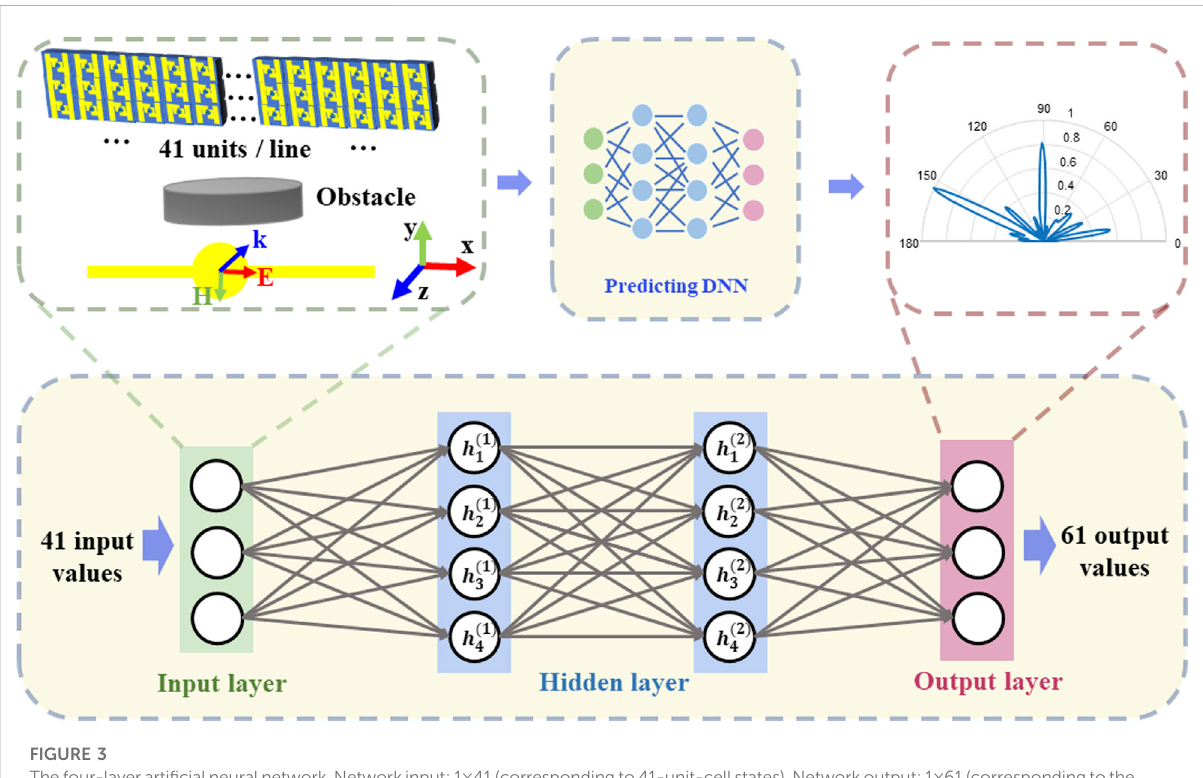
FIGURE 3 Thefour-layerarti fi cialneuralnetwork.Networkinput:1×41(correspondingto41-unit-cellstates).Networkoutput:1×61(correspondingtothe far- fi eld